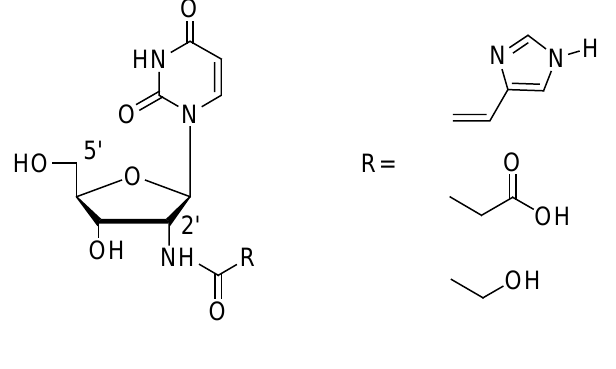
Figure 3 : 2’-Amido modified building